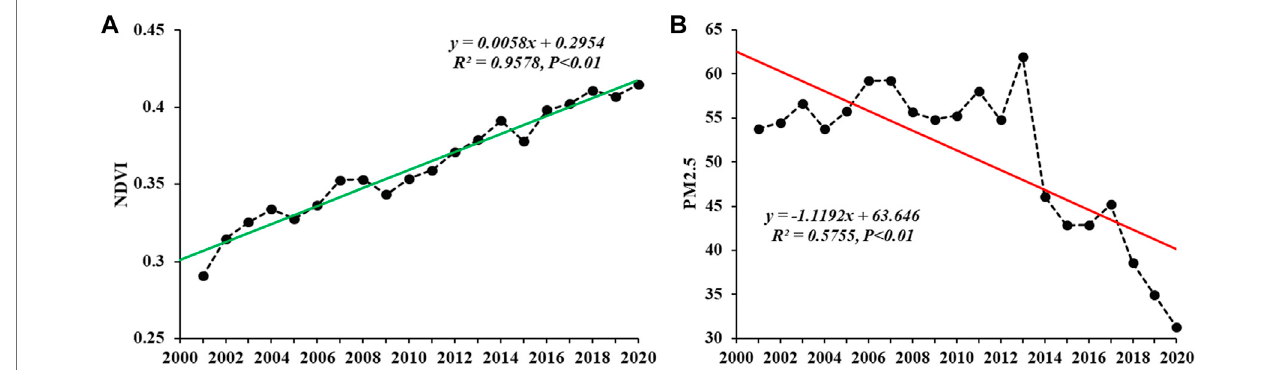
FIGURE 4 | Change trend of NDVI (A) and PM 2.5 (B) in the Shanxi Province from 2001 to